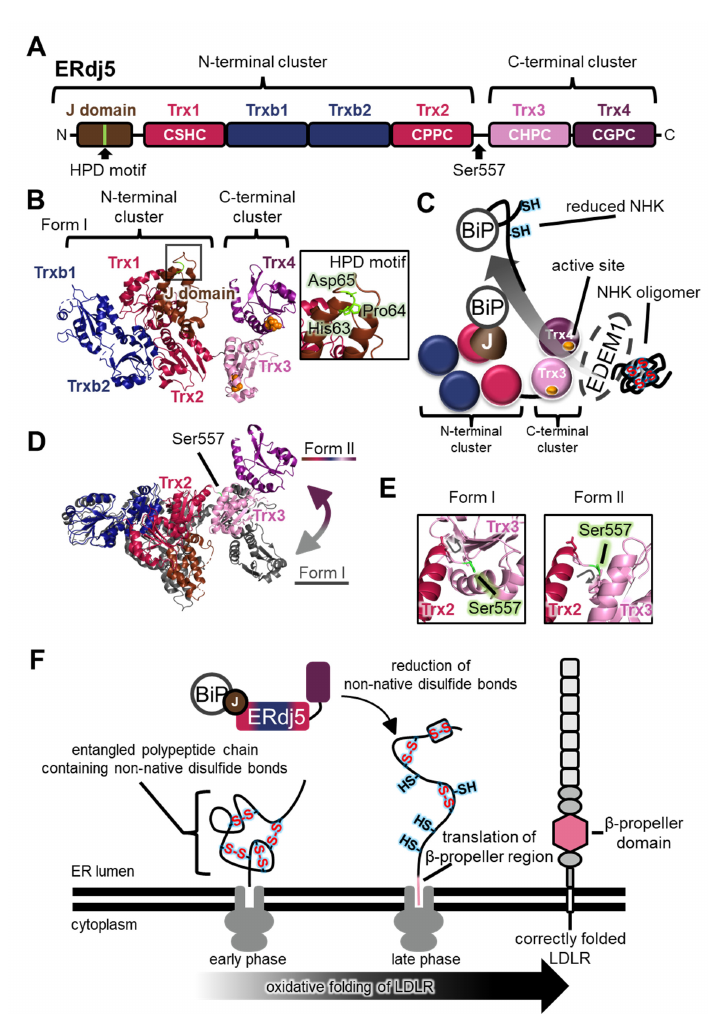
Figure 6. The highly dynamic nature of endoplasmic reticulum DNA J-domain-containing protein 5 (ERdj5) plays a key role in functional interplay with substrates. ( A ) Schematic representation of the ERdj5 domain structure. The position of the His-Pro-Asp (HPD) motif that is important for association with BiP and the Ser557 residue that is critical for linker flexibility are indicated. ( B ) (Left) Crystal structures of ERdj5 form I (each domain colored as in ( A ); PDB code: 5AYK). Redox-active sites in Trx3 and Trx4 are shown as orange spheres. (Right) Close-up view of the HPD motif in the J-domain is indicated. ( C ) Handling of the endoplasmic reticulum (ER)-associated degradation (ERAD) substrate null Hong Kong (NHK) oligomer by ERdj5. EDEM1 recognizes disulfide-linked NHK oligomers and associates with the C-terminal cluster of ERdj5 [68]. Active sites in Trx3 and Trx4 reduce the intermolecular disulfide bonds in NHK oligomer [68]. Finally, reduced NHK is delivered to BiP on the J-domain of ERdj5, and BiP dissociates from ERdj5 to recruit reduced NHK for retrograde translocation. ( D ) Superimposition of crystal structures of form I (gray; PDB code: 5AYK) and form II (each domain colored as in ( A ); PDB code: 5AYL). The C-terminal cluster is shifted upward relative to the N-terminal cluster in form II, suggesting movement between these clusters, as indicated by the two-way arrow. Ser557 in the flexible linker of form II is indicated. ( E ) Di ff erent orientations of Ser557 in form I and form II (each domain colored as in ( A )). Ser557 is colored in light green. Gray arrows indicate the orientation of the main chain between Trx2 and Trx3 in form I and form II, respectively. ( F ) Schematic model of co-translational oxidative folding of LDLR and reduction of non-native disulfide bonds by ERdj5 during the late phase. At the early phase of LDLR translation, non-native disulfide bonds are introduced co-translationally [69–71]. At the late phase, these non-native disulfide bonds are isomerized into native disulfide bonds [70–72], and ERdj5 probably plays a specific role with BiP in reducing non-native disulfide bonds